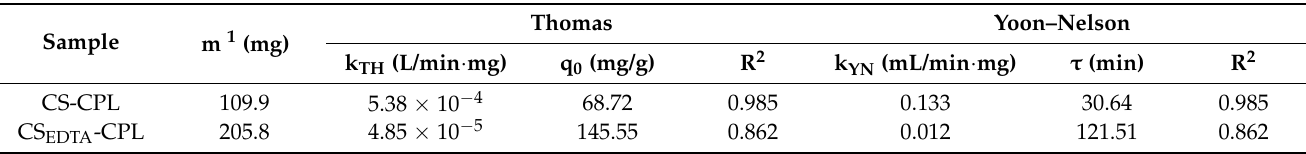
Table 3. Fitting parameters of Thomas and Yoon–Nelson models for the fixed-bed column